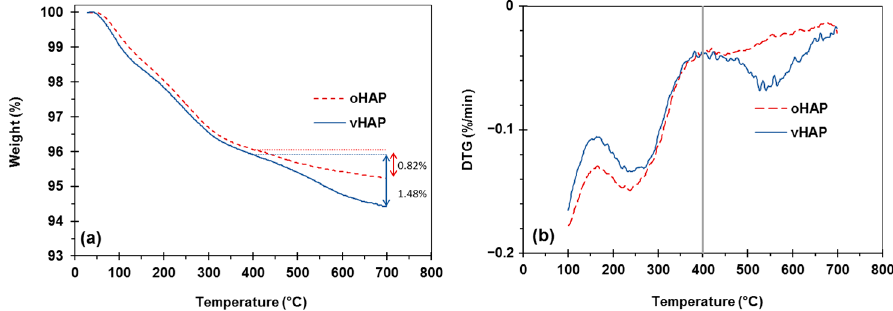
Figure 3. TGA and DTG curves of oHAP and vHAP; ( a ): TGA, ( b ) DTG.